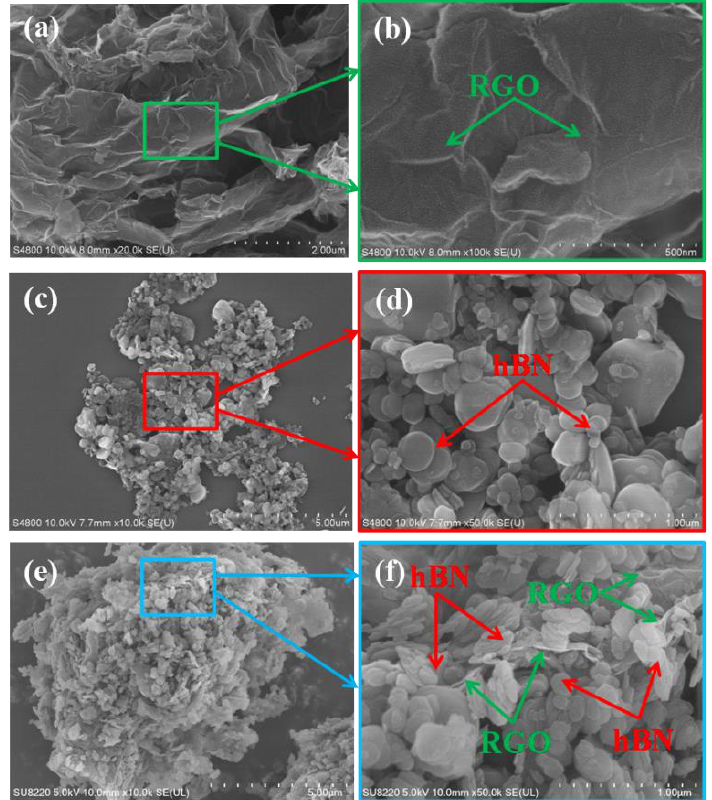
Figure 2. SEM images of ( a , b ) RGO, ( c , d ) hBN and ( e , f ) RGO-hBN at different magnifications.